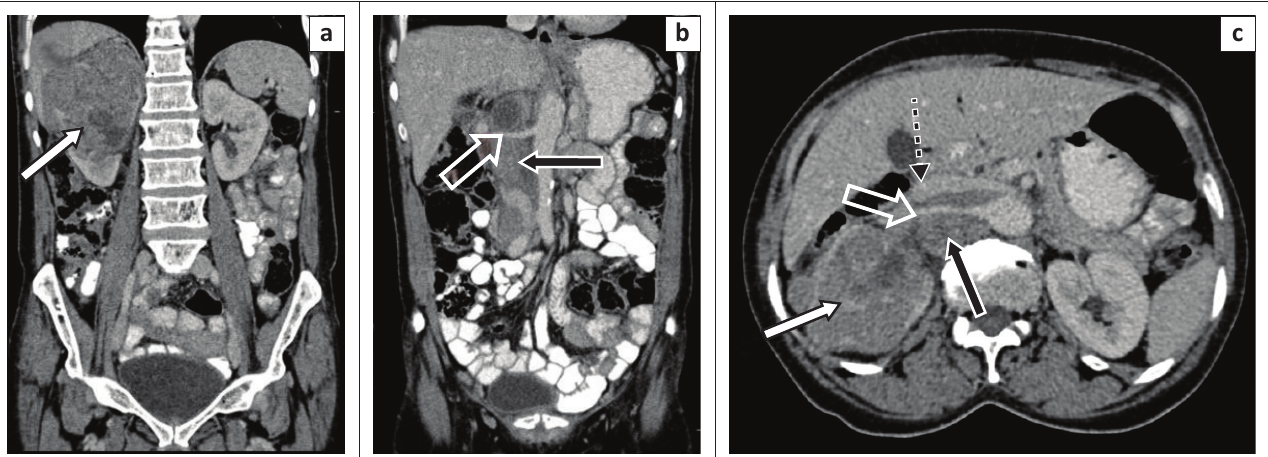
FIGURE 4: Coronal (a, b) and axial (c) contrast-enhanced portovenous phase computed tomography scan images demonstrate a large right renal mass with capsular rupture and tumour extension into the perinephric space (white arrow). Extensive metastatic retroperitoneal lymphadenopathy (black arrow) with encasement and subsequent narrowing of the right renal artery (open white arrow). There is also compression and anterior displacement of the inferior vena cava (IVC) (dashed black arrow). There was no tumour thrombus in the renal vein (not shown) and IVC. The findings of local tumour invasion involving the perinephric space and lymph node spread were confirmed at histology.